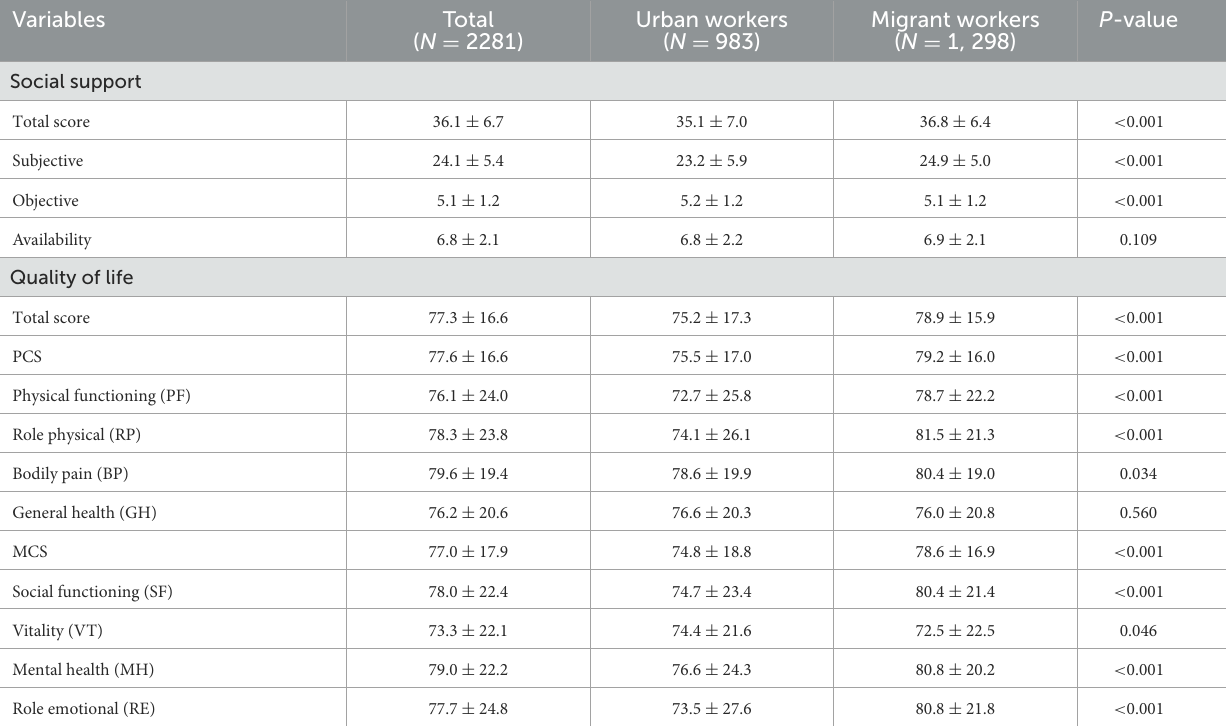
TABLE 2 Comparison of the scores for social support and quality of life between migrant and urban workers.